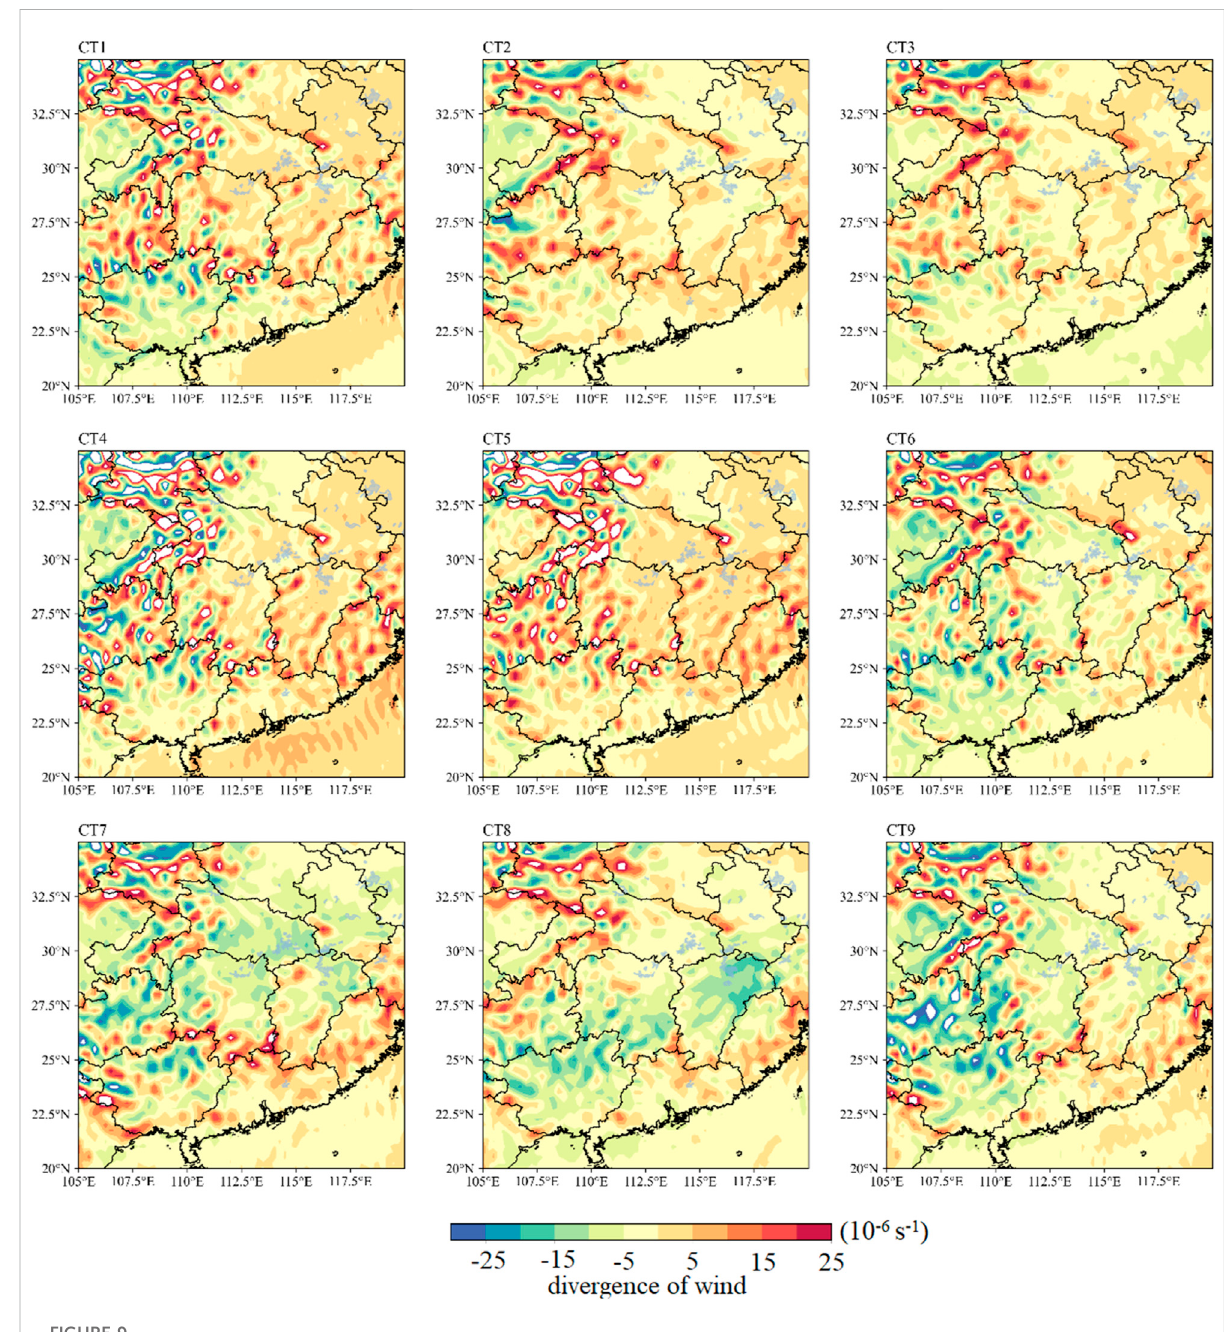
FIGURE 9 Average wind dispersion below 850 hPa under the nine CTs in the CZT